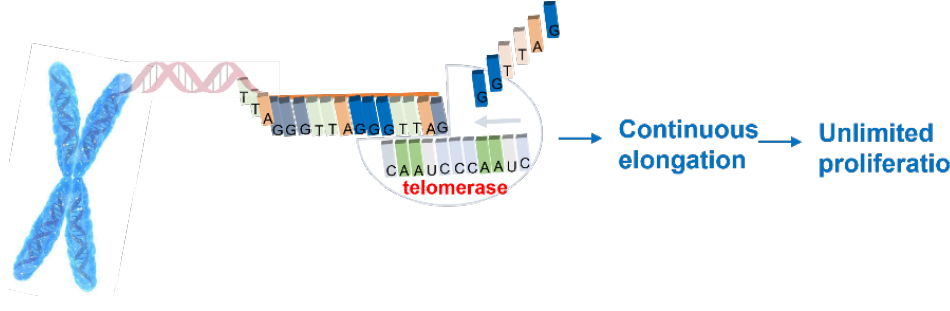
Figure 1. Telomerase function.